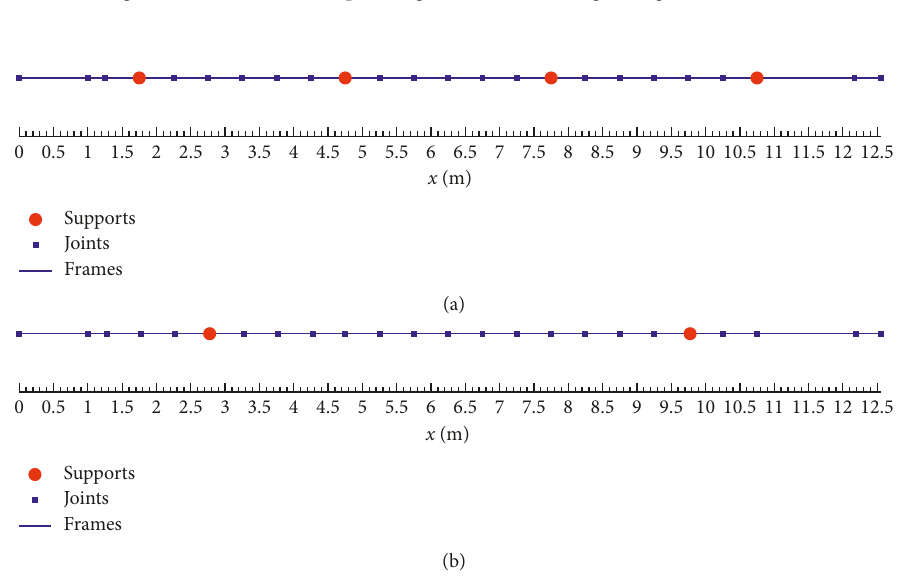
Figure 3: Longitudinal sections with span length of the two bridge design alternatives (G1 and G2).